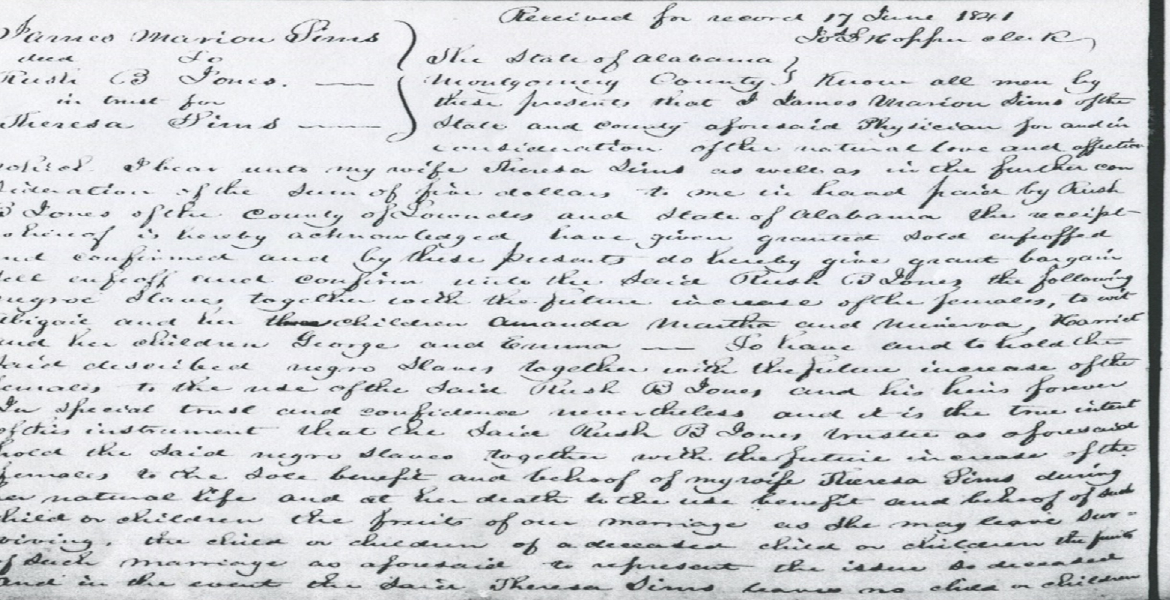
Figure 2. “James Marion Sims Property Deed to Rush B. Jones in trust for Theresa Sims” Montgomery, County 1841. Copyright of the Alabama Department of Archives and History. According to the document above, Sims agreed to: [H]ereby give grant bargain sell enfeoff and confirm into the said Rush B Jones the following negroe slaves together with the future increase of the females, to wit Abagail